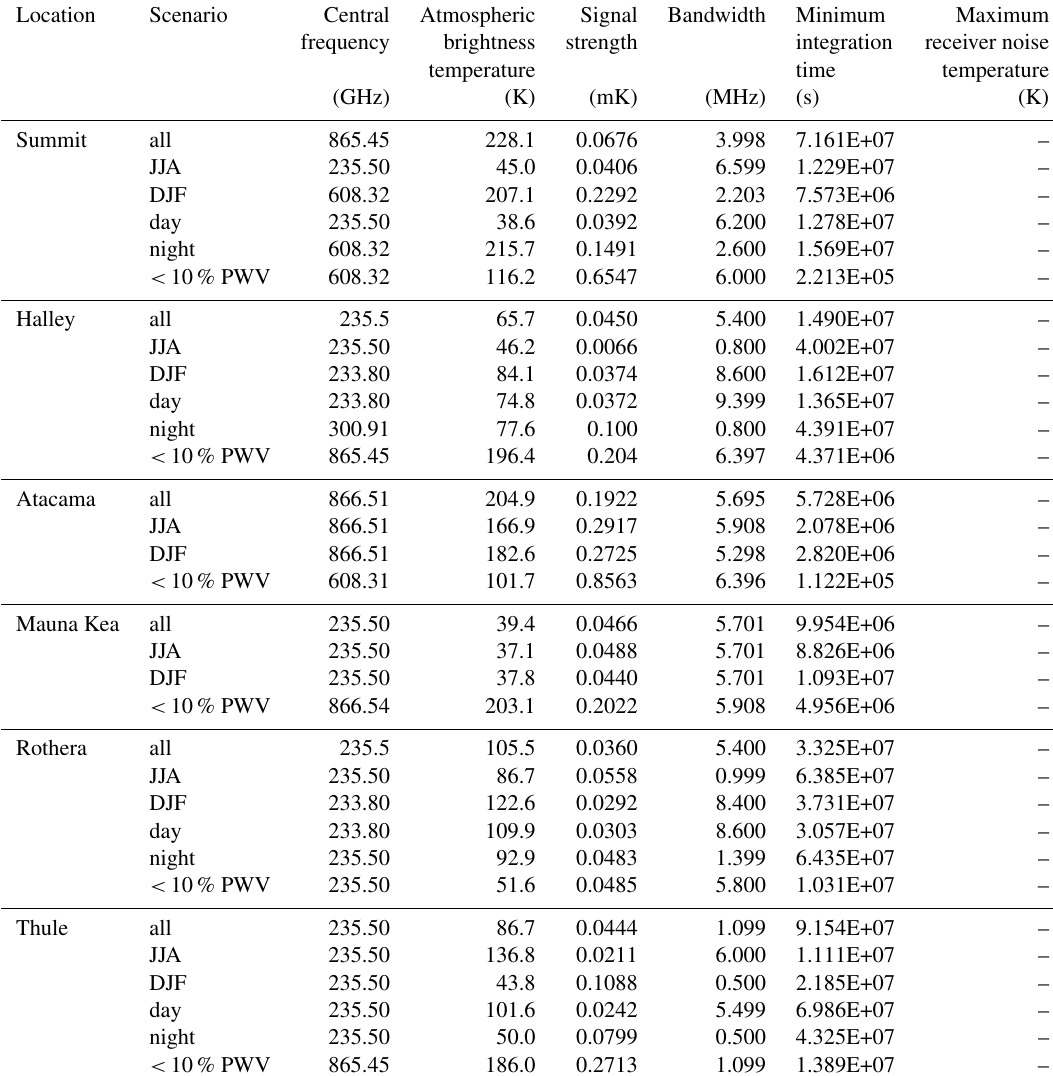
Table 6. As Table 5 but for HOBr.